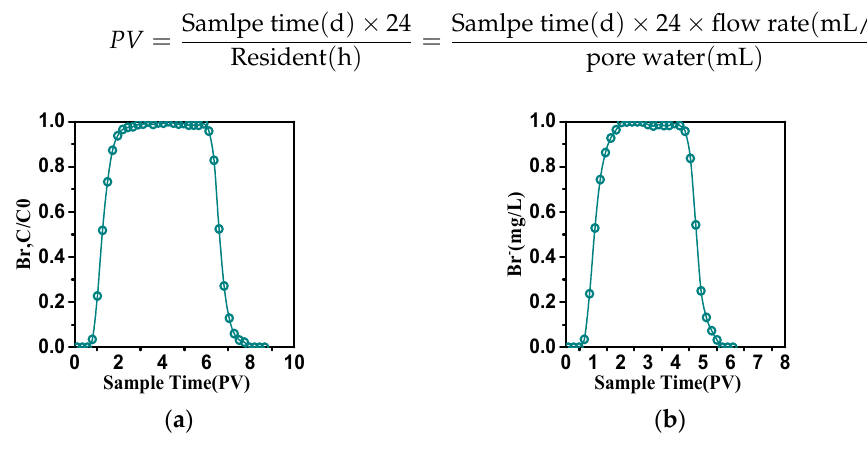
Figure 1. Br breakthrough curve. ( a ) Column A. ( b ) Column B.